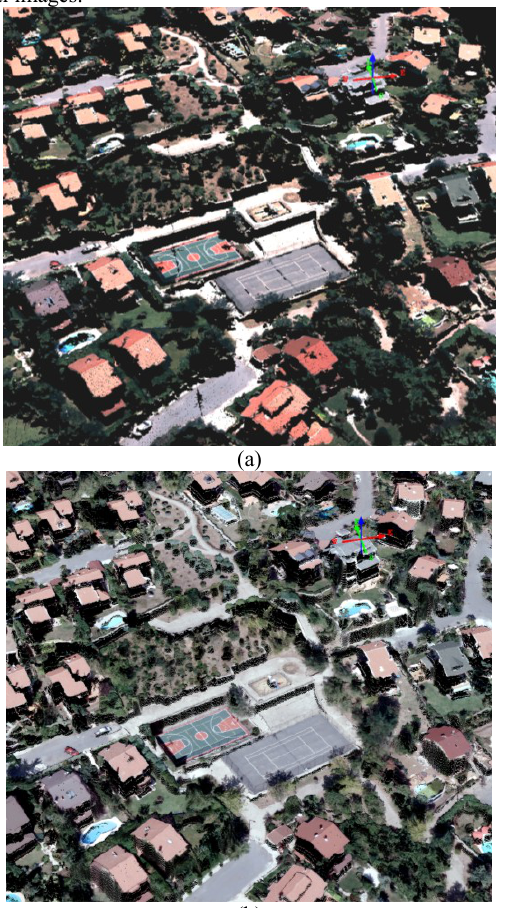
Figure 4. The computed elevation differences for DLR DSM (a) and UltraMap DSM (b) in